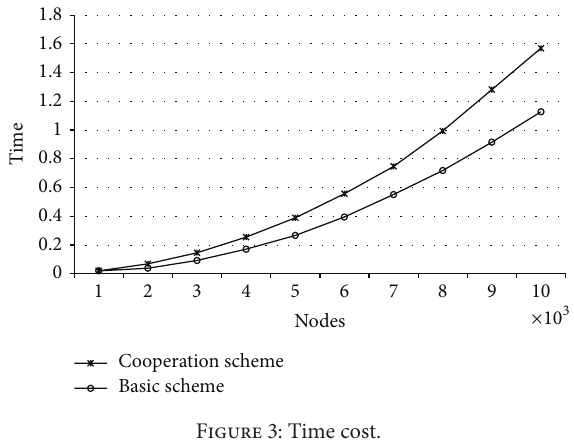
Figure 3: Time cost.